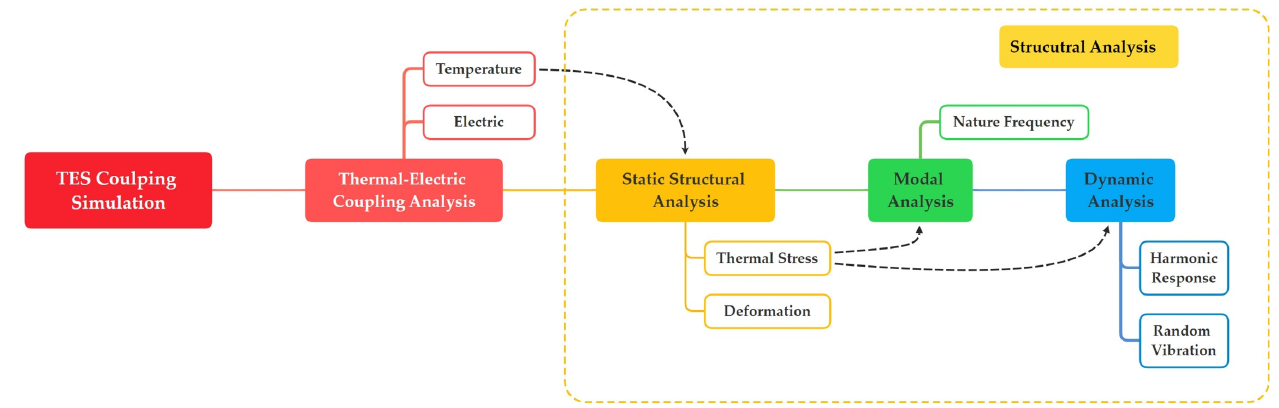
Figure 6. A schematic illustration of the TES coupling simulation for wet-mateable electrical connectors.